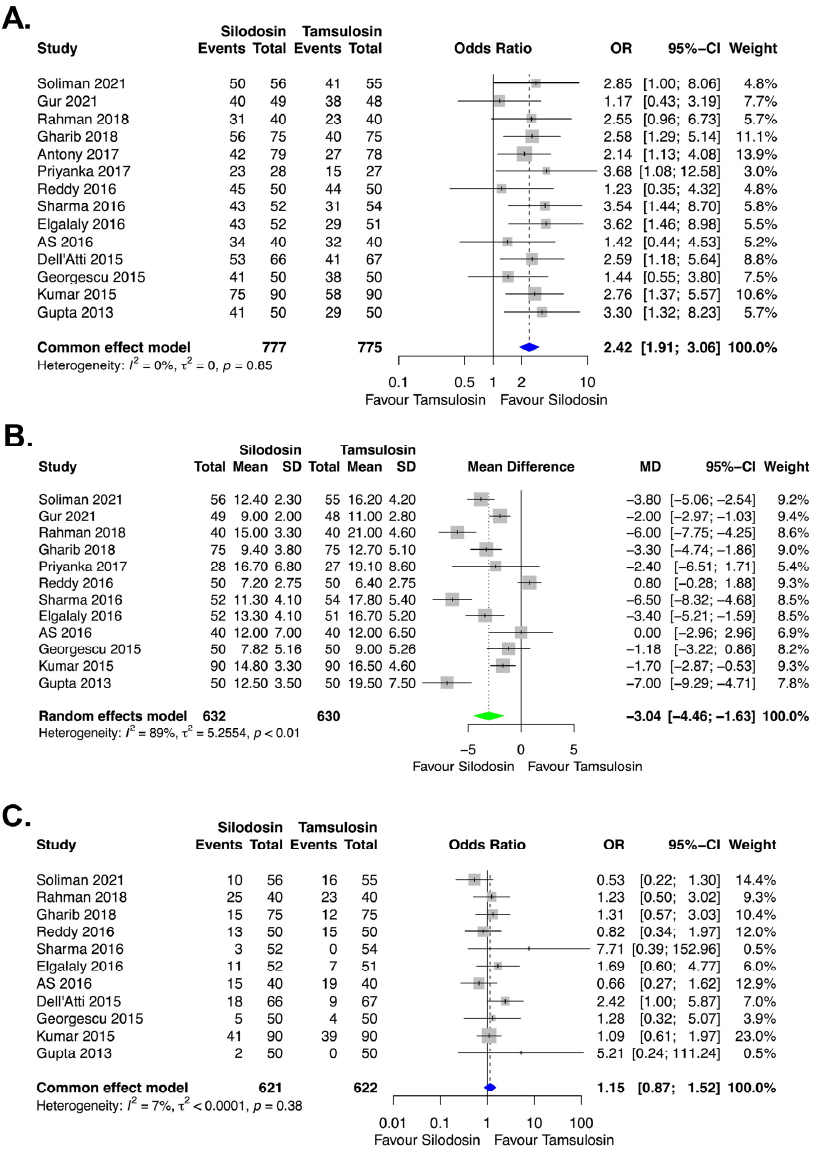
Figure 5. Forest plots: ( A ) stone expulsion rate, ( B ) stone expulsion time, and ( C ) total complication rate. CI, confidence interval; MD, mean difference; OR, odds ratio; SD, standard deviation.